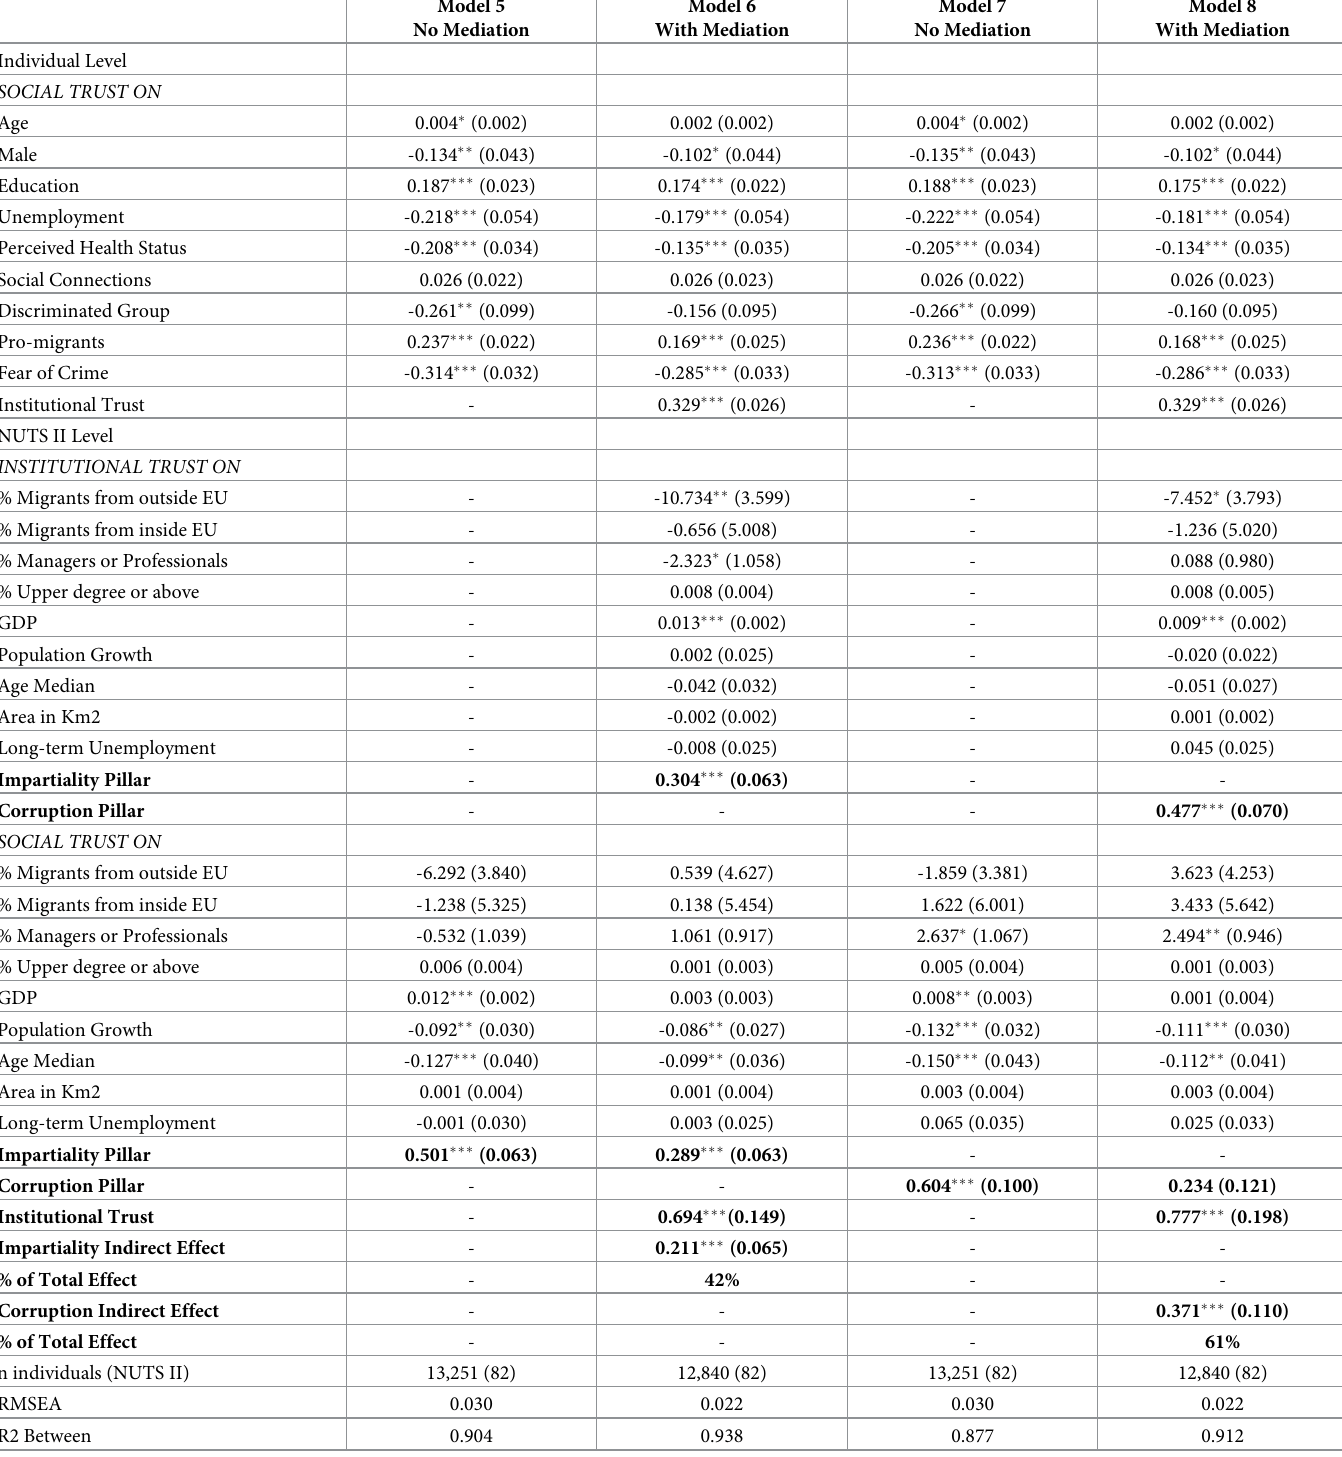
Table 4. MSEM testing the mediation effect of institutional trust on the relationship between fairness and social